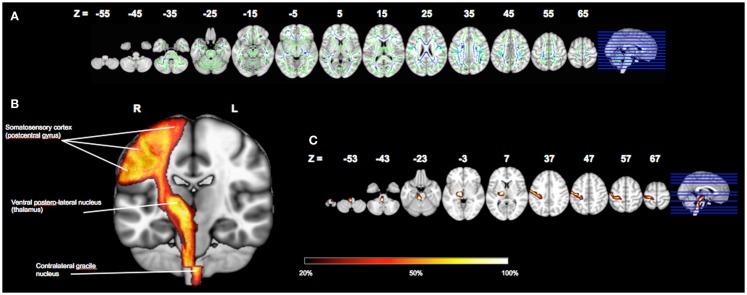
Whole brain voxelwise tract-based spatial statistical (TBSS) analysis of radial diffusivity (A). Voxels with significantly poorer white matter quality in PwMS are shown in blue (TFCE, multiple comparison corrected; P < 0.01) and are overlaid on the TBSS skeleton (green). Bilateral Brodmann area 3a is highlighted in light blue (Z = 25–55), the ventral posterolateral nuclei of the thalamus in pink (Z = 5) and the gracile nuclei in red (Z = −55). Data are displayed in MNI space and radiologic convention. The right hemisphere’s cortical proprioceptive pathway identified within all study participants [(B,C); left hemisphere not shown]. The color bar indicates the percentage of participants with identified tracts in each region. All data are displayed in MNI space and radiologic convention.